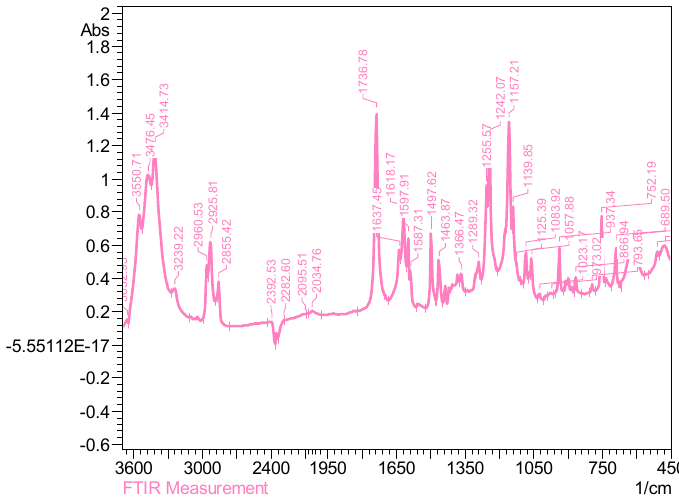
Figure 3. FTIR spectra of decyl phenoxyethyl adipate.